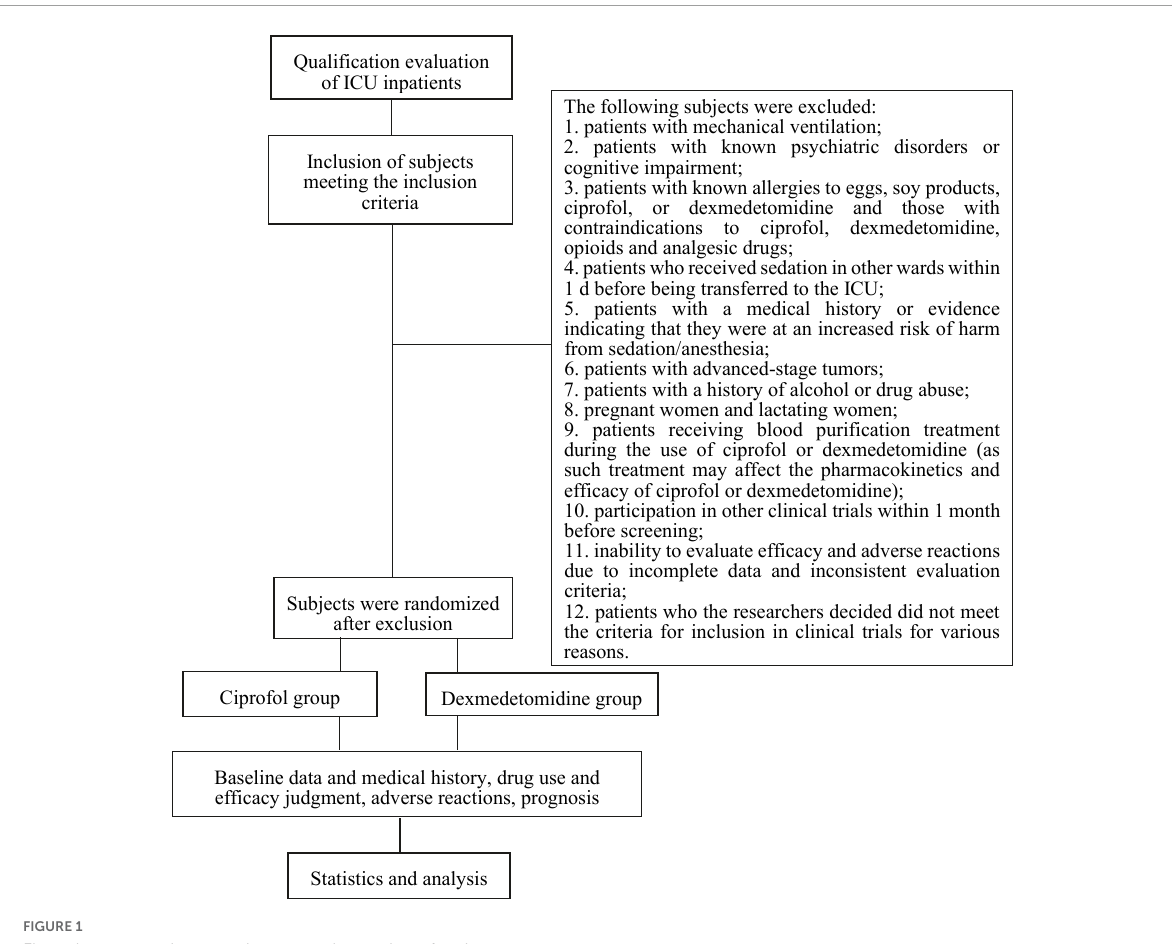
the inclusion and exclusion criteria, patients were enrolled and randomly assigned to receive continuous intravenous sedation with ciprofol, dexmedetomidine, or normal